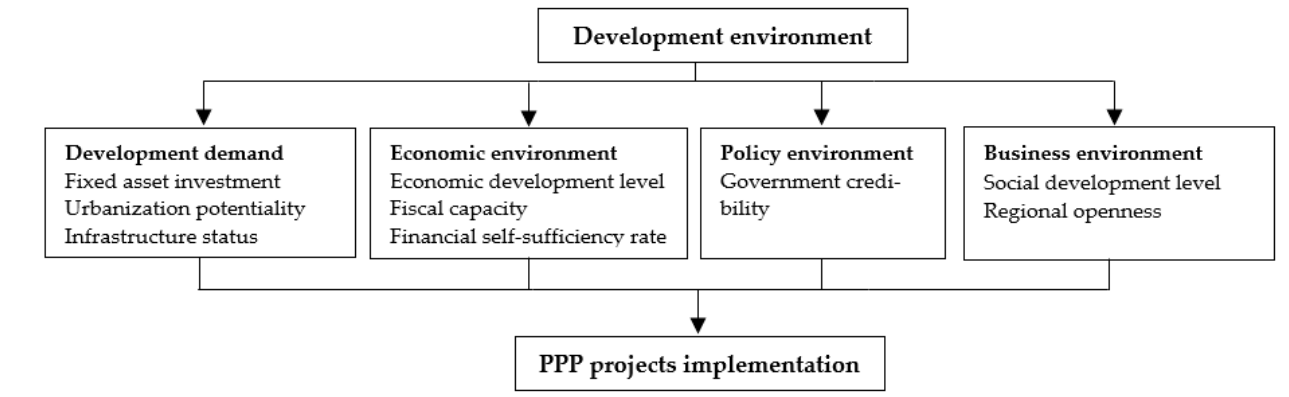
Figure 1. The analytical framework for driving factors of PPP project implementation.